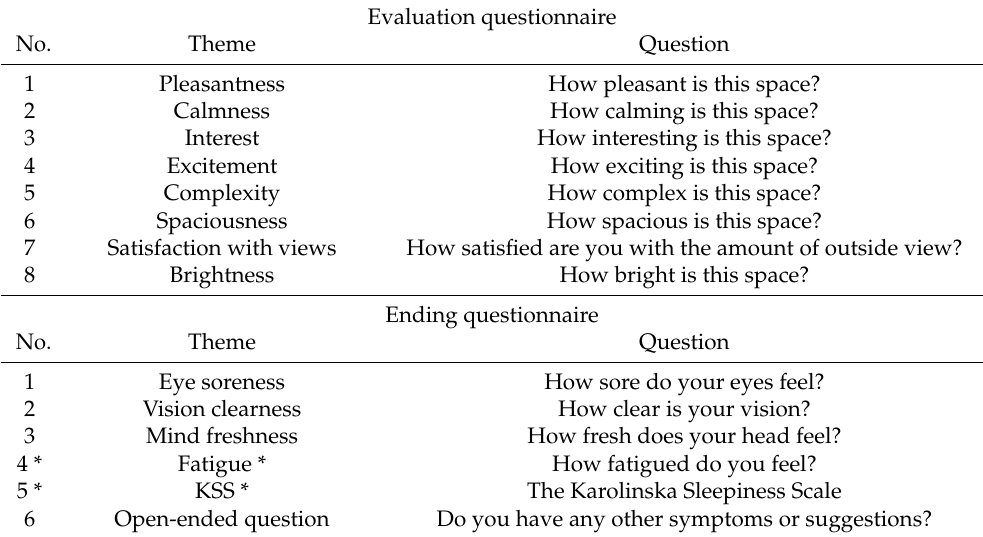
Table 1. The evaluation questionnaire and ending